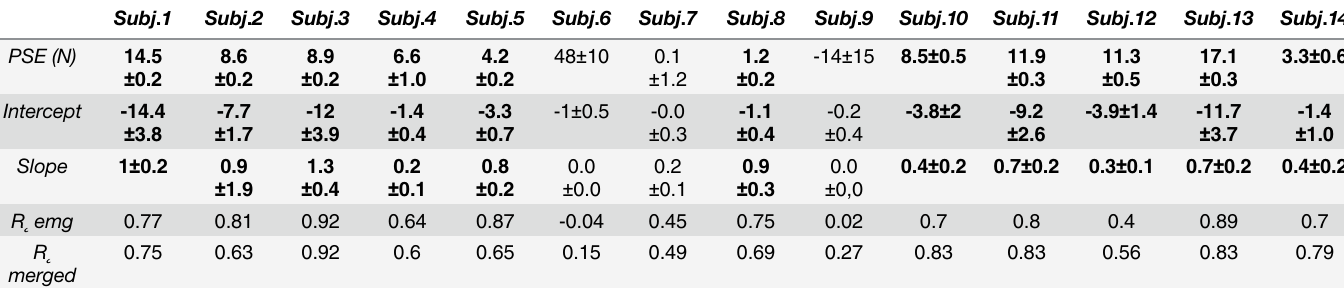
Table 2. Muscular-Metric Parameters. Individual ML threshold, intercept and slope parameters ± SE obtained by Logit glm fit describing the percentage of muscular activation (namely, PoolEmg > criterion) as function of upward force level presentation. R 2 emg values describe, per each subject, the explained variance of the Logit function used to account for the probability of PoolEmg > criterion at each force presented. An index of similarity ( R 2 merged ) between the two metrics was defined as the goodness of fit of a Logit function explaining both perceptual and muscular probabilities merged together. Thus, R 2 merged represents the level of concordance between muscular and perceptual performances in describing the subjects ’ decision about upward forces. Participants 6 and 9 were excluded from further analysis since Logit function could not reliably explained their probability of pooled muscular activation over criterion (R 2